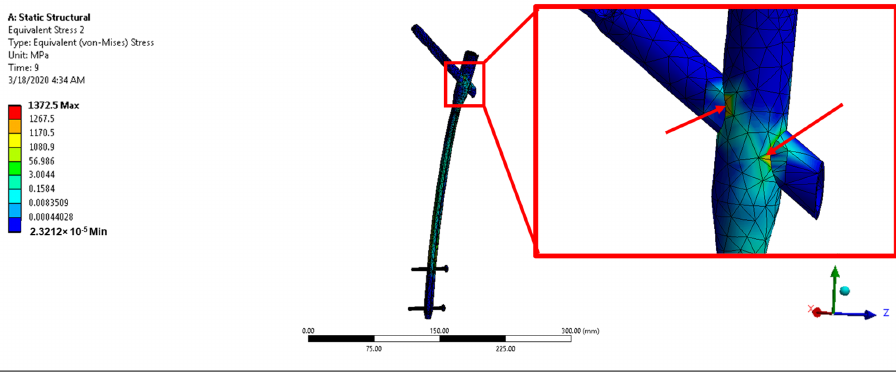
Figure 21 . The von Mises stress distribution across the femoral CM nail fixation device showing the maximum stress on the contact area between the femoral CM nail and the helical screw (red arrows).